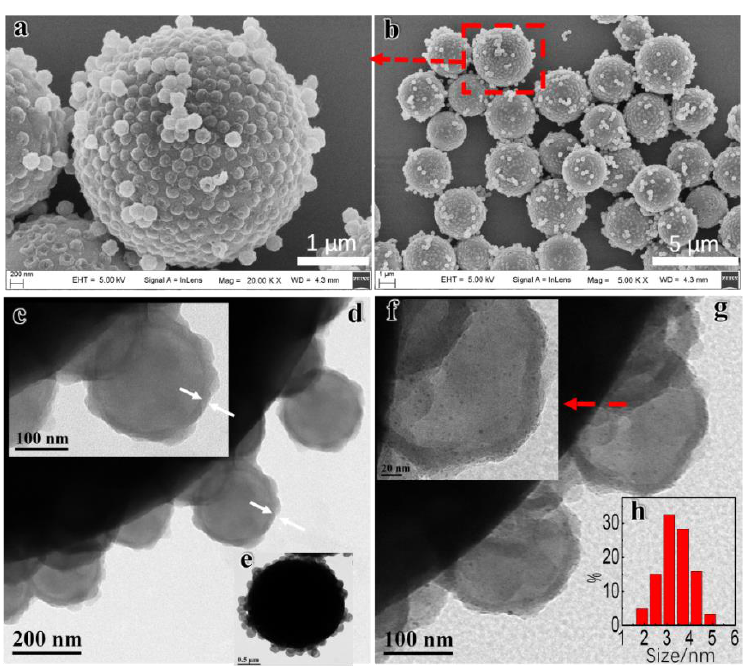
Figure 1. SEM images of hollow-spheres-on-sphere (HSOS) particles at ( a ) high and ( b ) low magnification; TEM images of HSOS particles at ( c – e ) different magnification which show hollow nanospheres with 200 nm core and 25 nm shell; TEM images of an Au/HSOS particle at ( f , g ) different magnification and ( h ) the particle size distribution of Au nanoparticles.